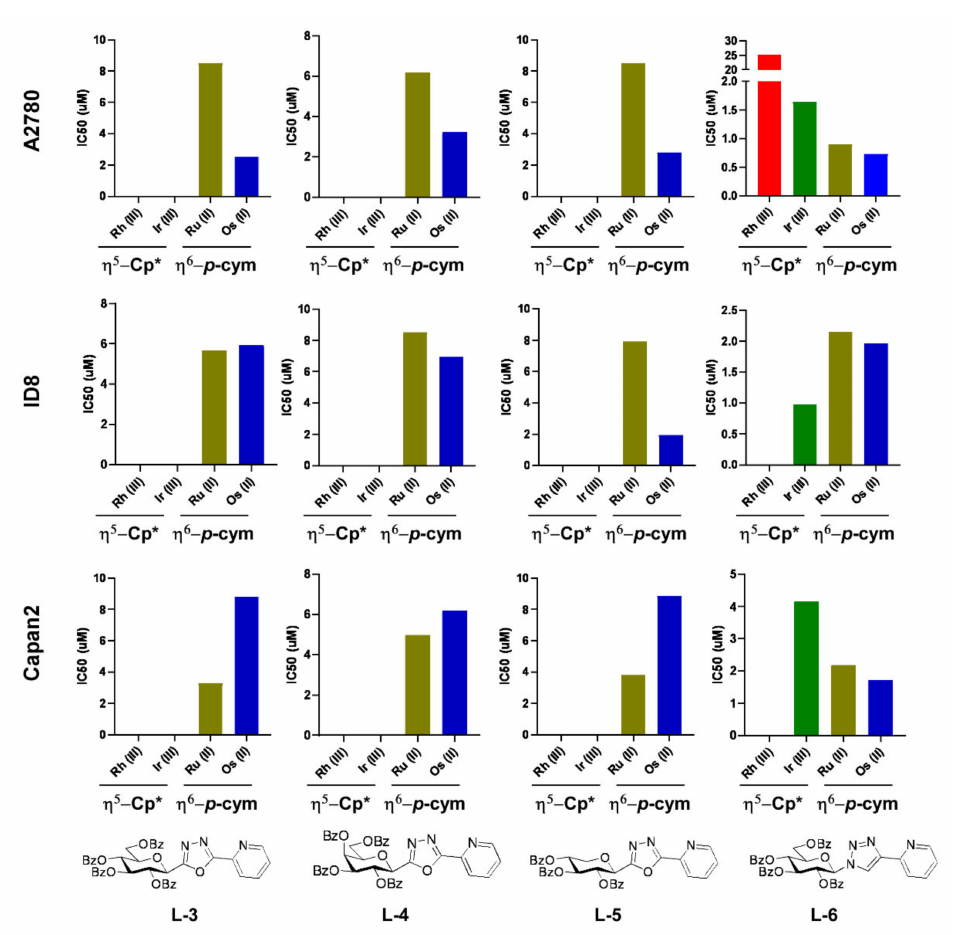
Figure 11. Structure–function relationship between complexes of L-3-L-6 ligands. Empty bars represent experiments where the calculation of the IC 50 values was not